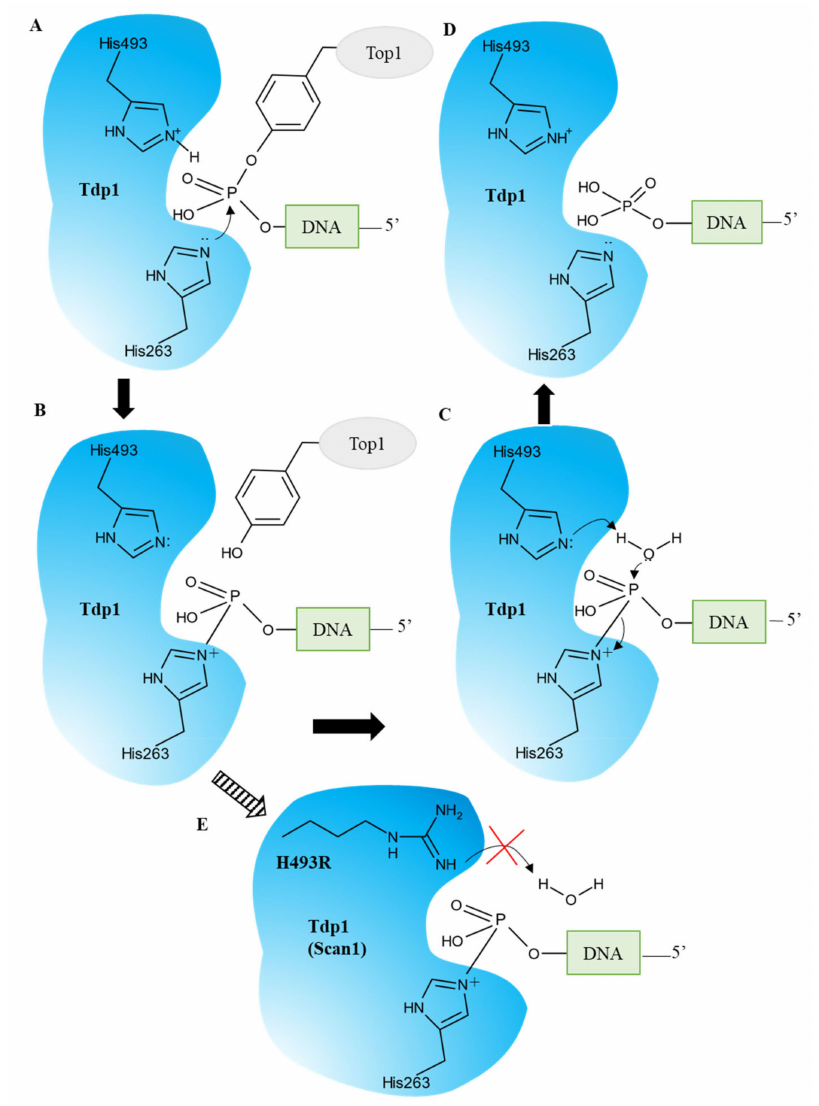
Figure 2. TDP1 (cid:48) s catalytic cycle. ( A ) The nucleophilic attack of the phosphodiester backbone by the imidazole N2 atom of H263. H493 donates a proton to the tyrosyl moiety of the leaving group. ( B ) The phosphohistidine covalent intermediate. ( C ) The second nucleophilic attack mediated by a water molecule activated by H493. ( D ) The emergence of the final 3 (cid:48) -phosphate product and free TDP1. ( E ) The SCAN1 mutation (H493R) leads to the accumulation of the TDP1–DNA intermediate and a fall in the TDP1 turnover